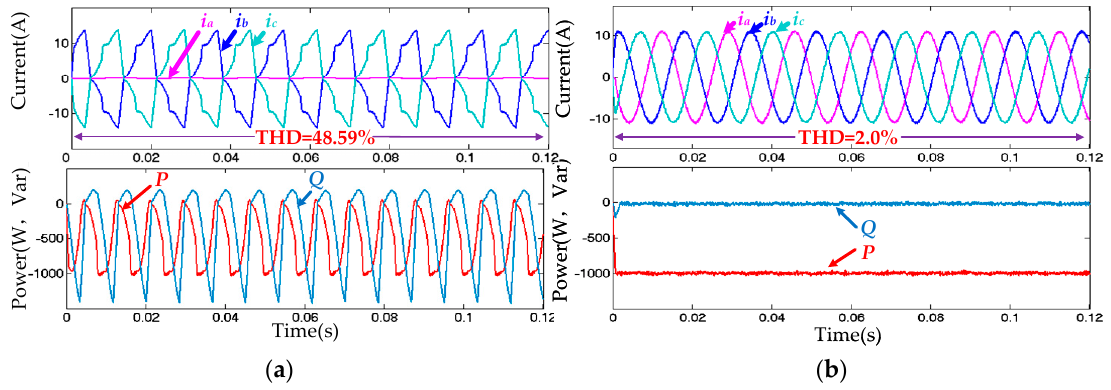
Figure 8. Simulation results in rectifier mode with leg faults of phase a. ( a ) Traditional BVSC; ( b ) Proposed MPDPC for fault-tolerant BVSC.